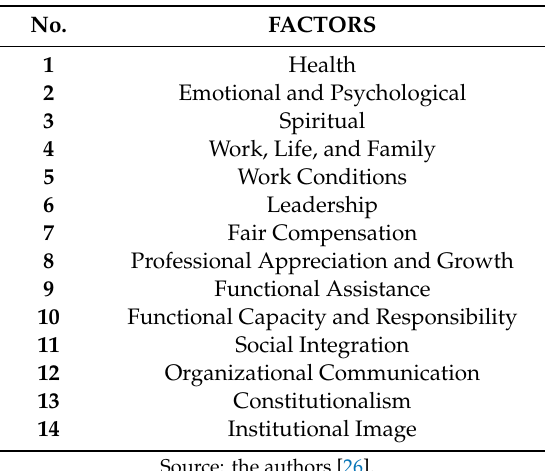
Table 1. Factors of the theoretical